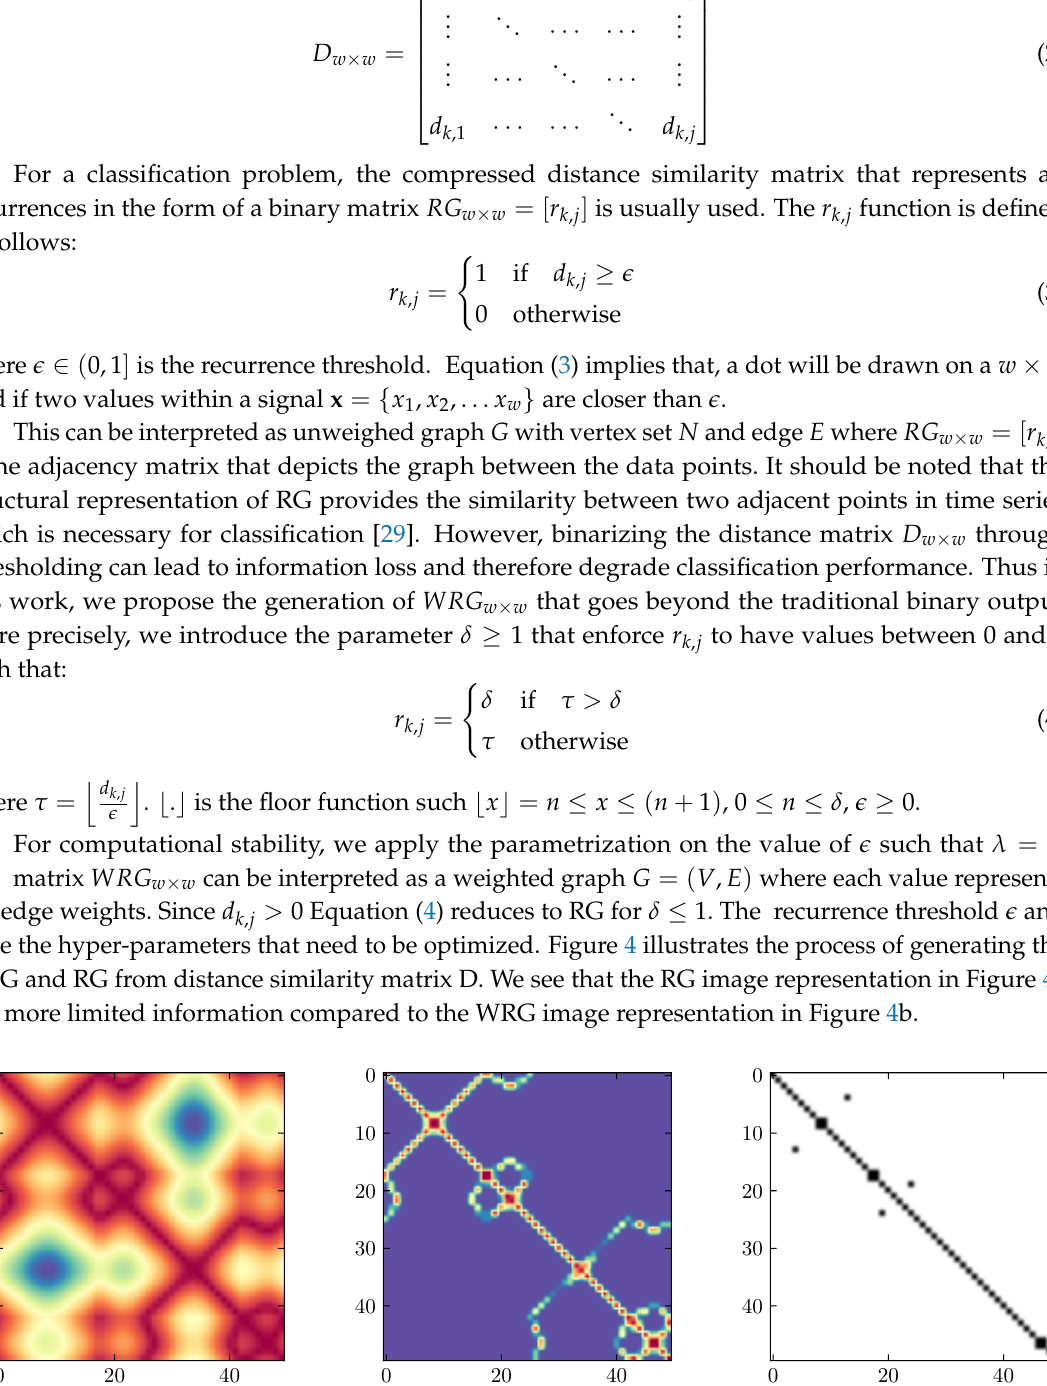
w ; ( b ) WRG matrix WRG w ×